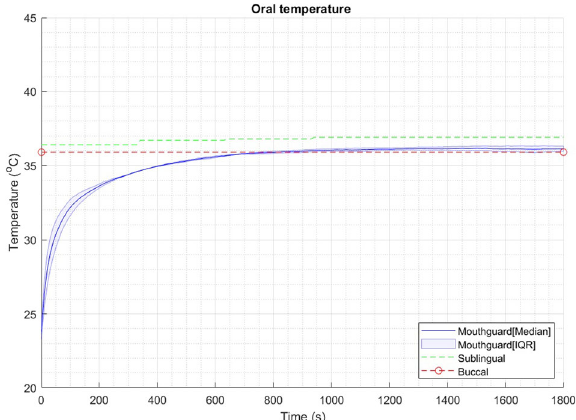
Fig. 5 Oral temperature readings. Mouthguard temperature sampled every 10 s, sublingual temperature sampled with single- use thermometers every 5 min, buccal temperature sampled with single-use thermometers before and after placing the mouthguard. The exact time points for buccal measurements are shown as red